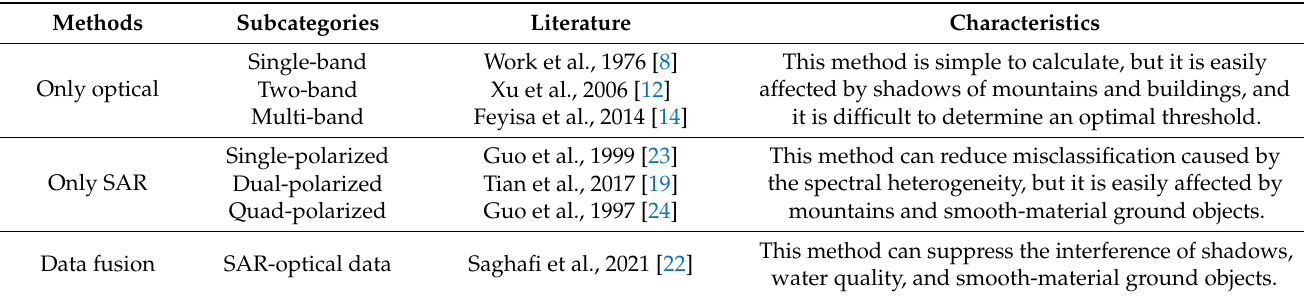
Table 1. The reviewed works of LWB